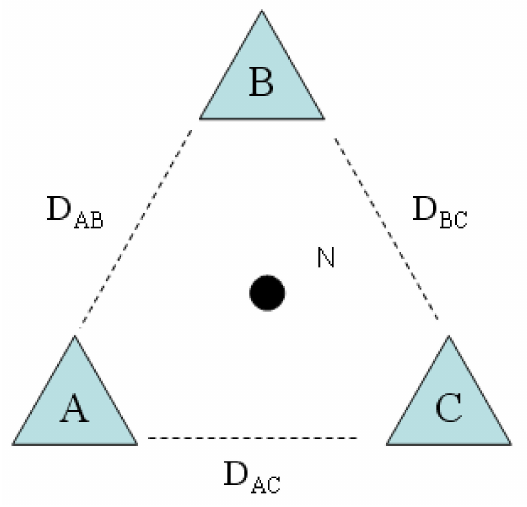
Figure 3. External distance for the external distance